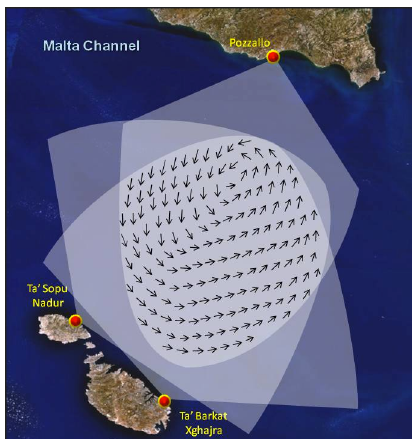
Figure 12. The Calypso High Frequency (HF) Radar platform: Schematics (after the Calypso Project web portal).